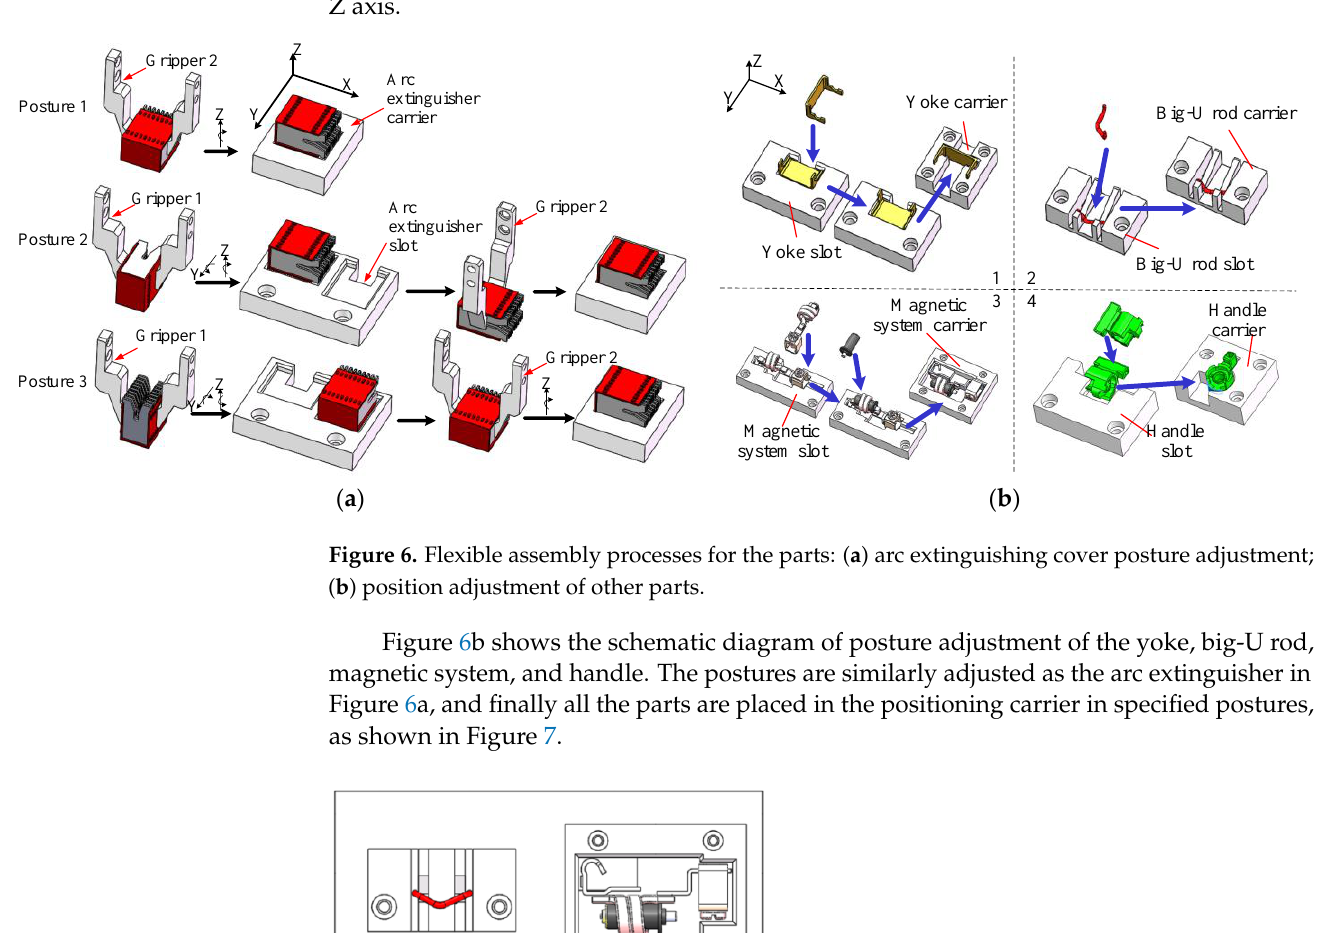
Figure 7 . Positioning carrier with adjusted parts.